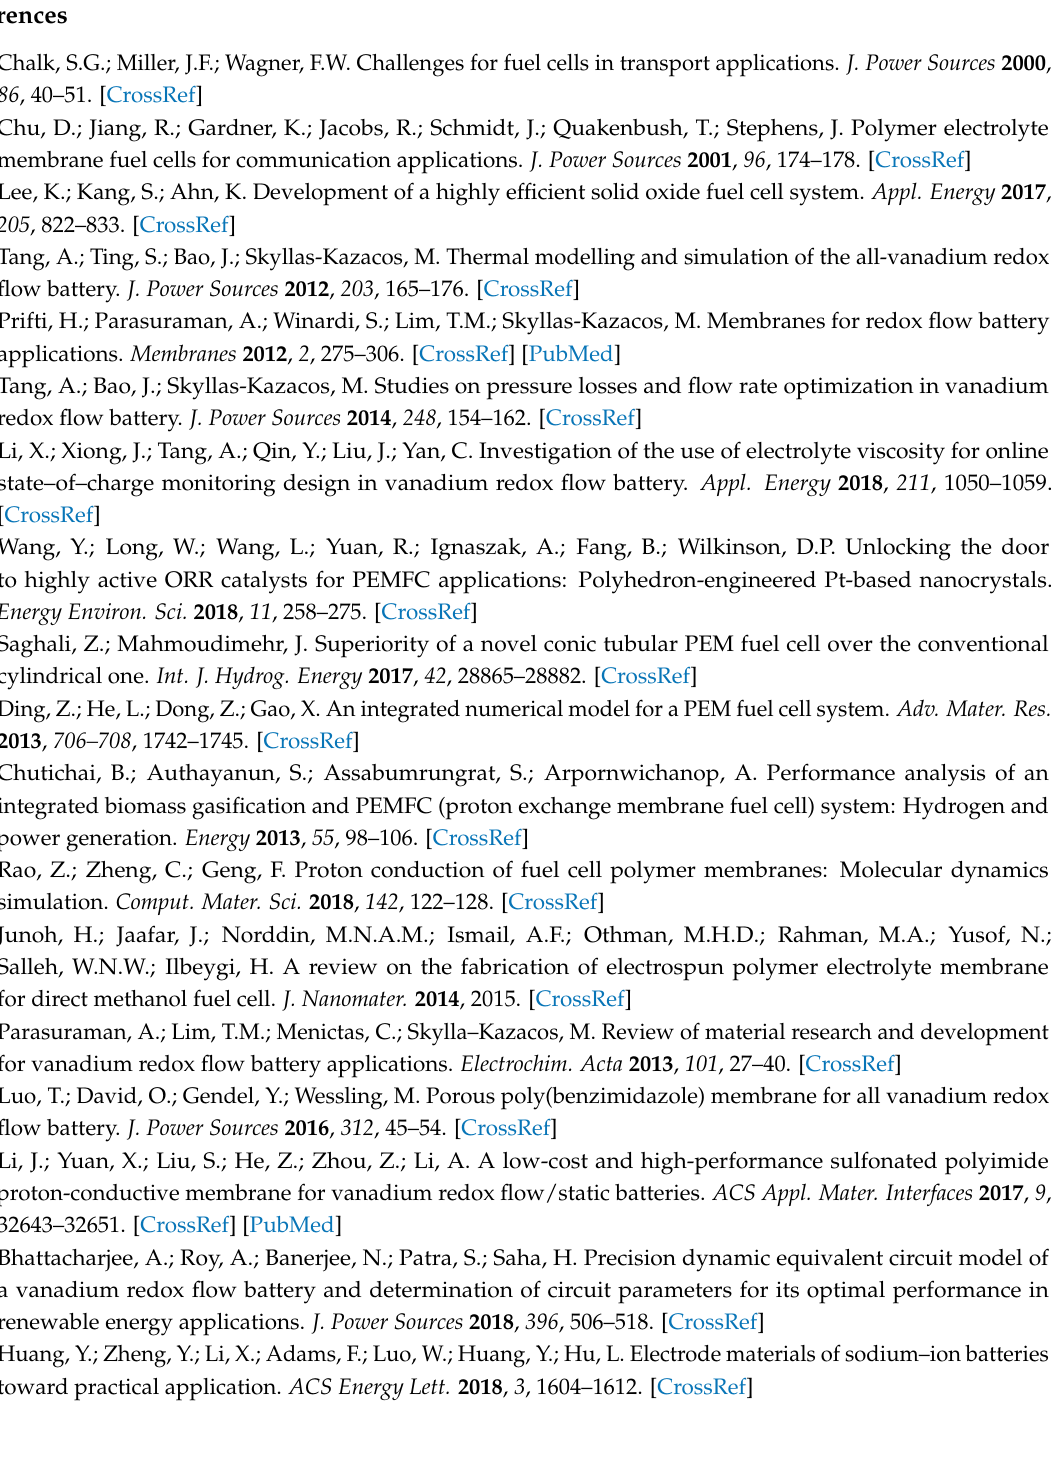
the influencing variables, Table S2: Points of the experimental design and target value DG, Table S3: Additional points to the experimental plan and target value